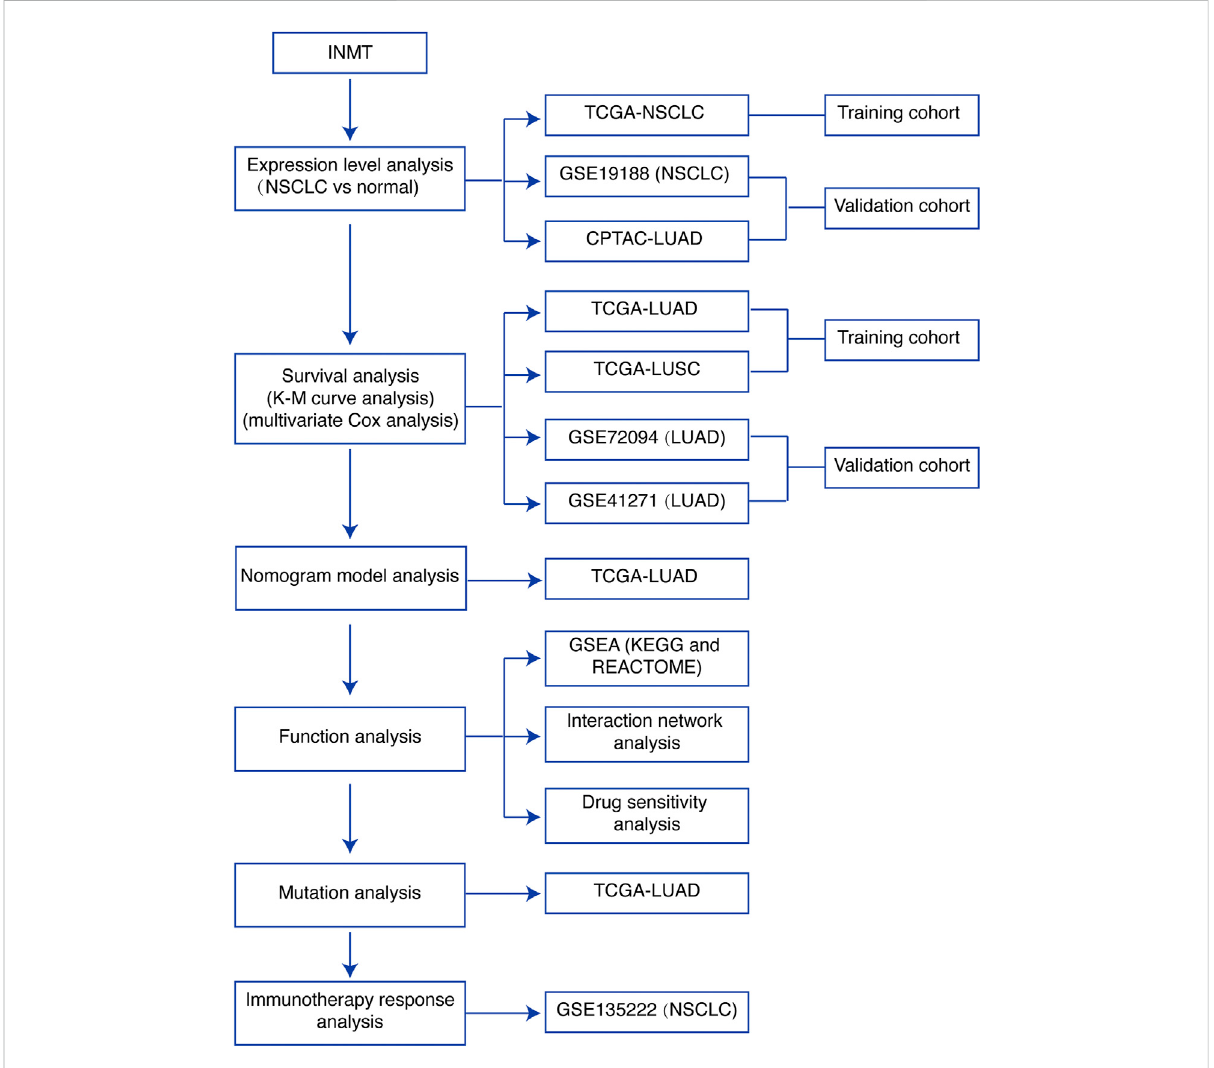
FIGURE 1 Study fl owchart. INMT, indolethylamine N-methyltransferase; NSCLC, non-small-cell lung cancer; LUAD, lung adenocarcinoma; LUSC, lung squamous cell carcinoma; TCGA, The Cancer Genome Atlas; K-M curve, Kaplan – Meier survival; GSEA, gene set enrichment